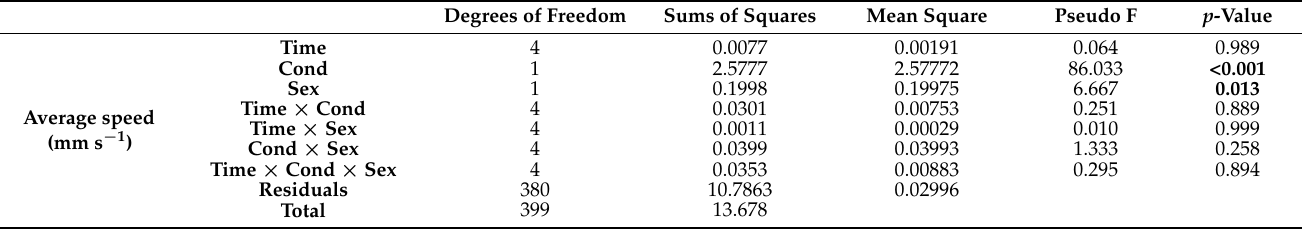
Table 3. Three-way interaction PERMANOVA summary for the three studied trajectory parameters (9999 permutations; α = 0.05, input distance matrix = Euclidean); significant differences in bold. Degrees of Freedom Sums of Squares Mean Square Pseudo F p -Value